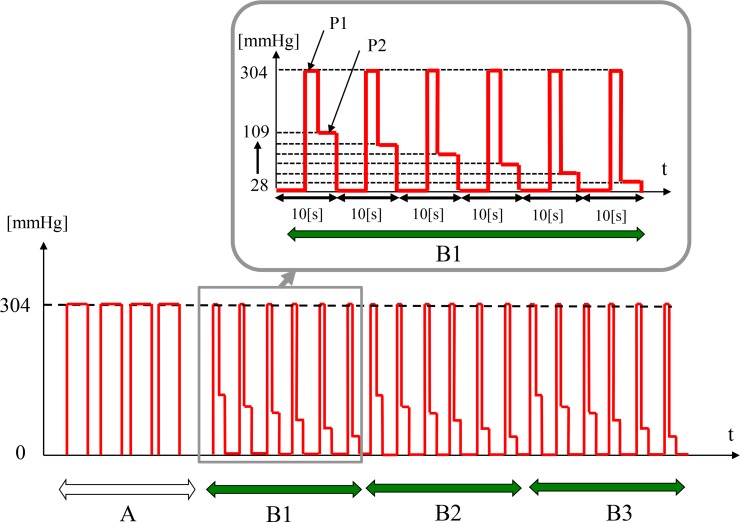
Time chart of pressure applied to the skin surface using the optical sensor with a pressurization mechanism.In section A, the absorption of light by the dermal tissue is estimated. In section B1-B3, blood reflow characteristics of the peripheral blood vessels are recorded by changing P2.